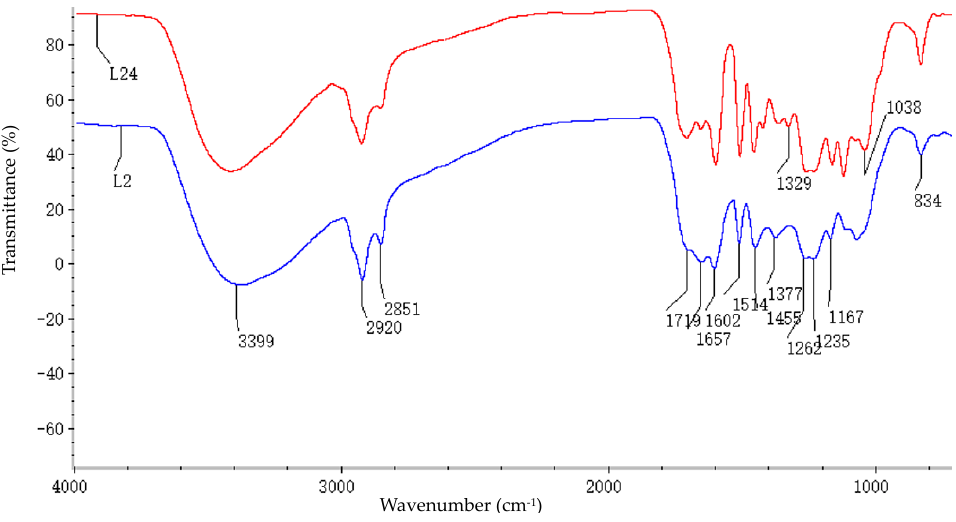
Figure 1. FT-IR of the lignin-carbohydrate complex (LCC) preparations (L 2 and L 24 ).